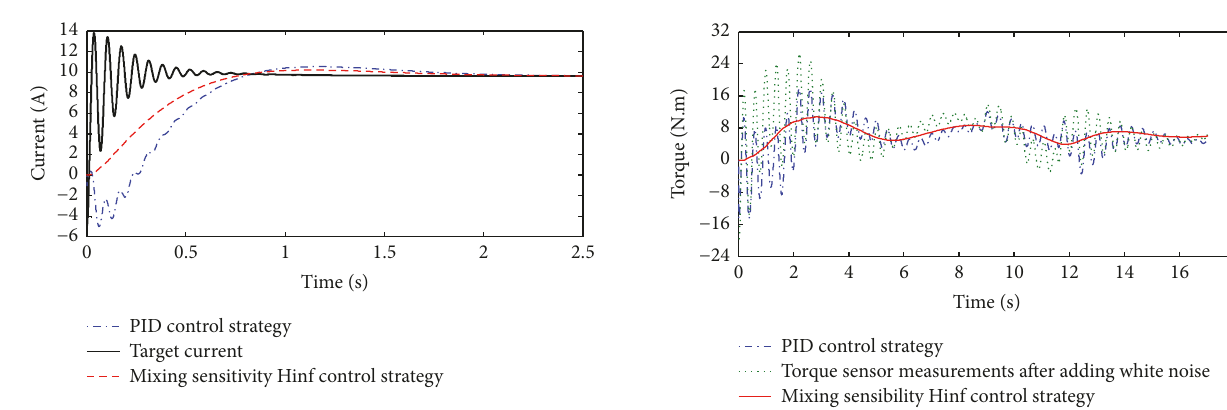
Figure 6: Torque sensor measurement response comparison chart.